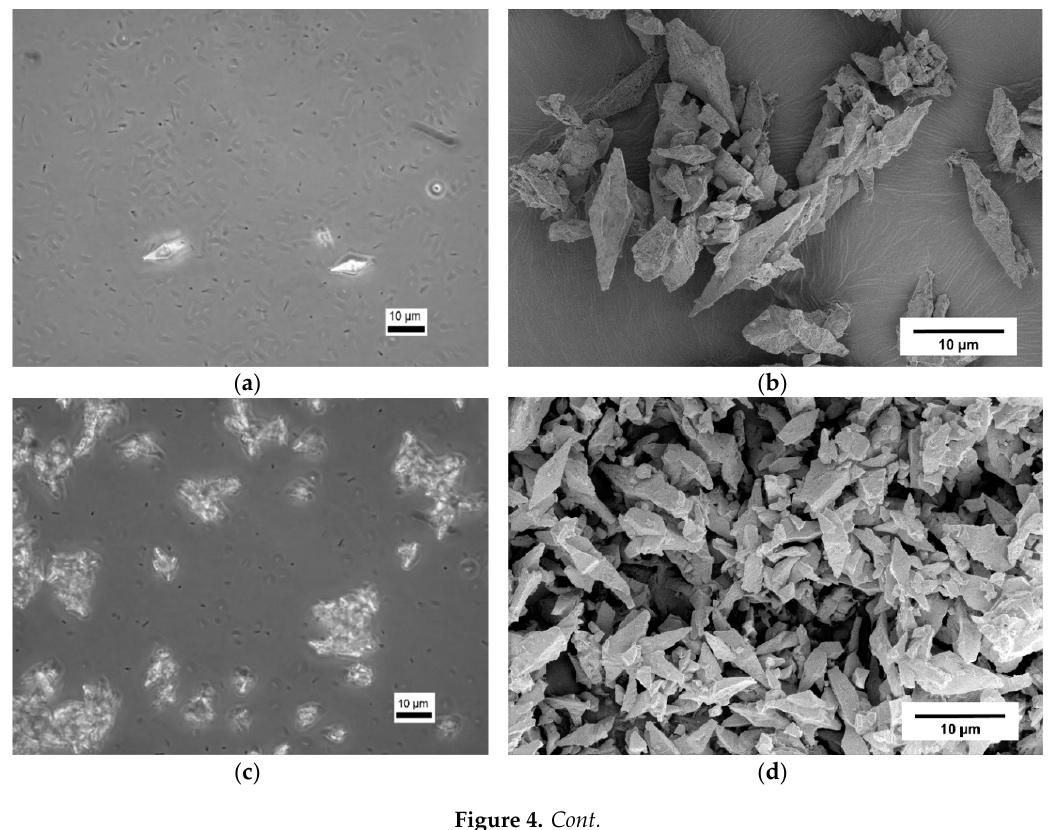
Figure 4. Cont. Figure 4.